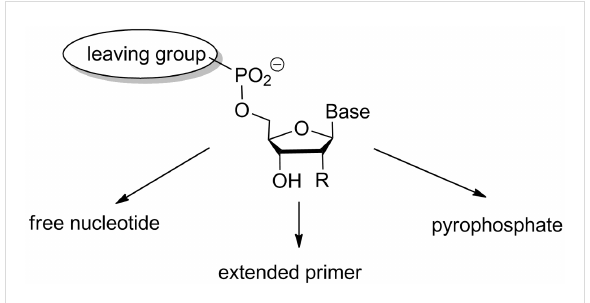
Figure 6: Three possible fates of activated nucleotides in aqueous buffer that result from hydrolysis, primer extension, and reaction with a free nucleotide, respectively. Other possible pathways, such as cycli- zation to the 3',5'-cyclic diester or oligomerization are not shown graphically; R is OH for ribonucleotides and is H for deoxynucleotides.